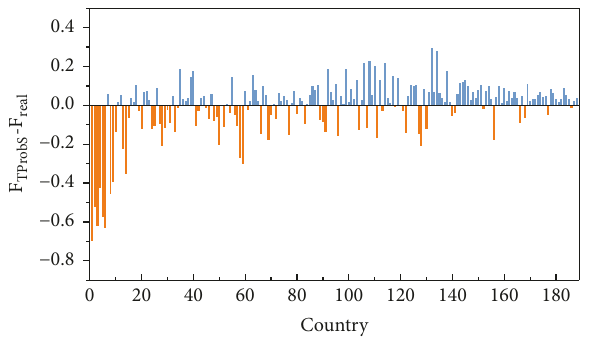
Figure 7: Difference of fitness resulting from following recom- mendation of TProbS and real evolution. The countries are sorted according to their fitness value, country 0 being the one with the highest average fitness. Each bar represents a country. The recommendation is performed at year 𝑇 for year 𝑇 + 5 , with 𝑇 ranging from year 2001 to 2010. 120 countries of the 181 countries would see their fitness improve by following the recommendation of